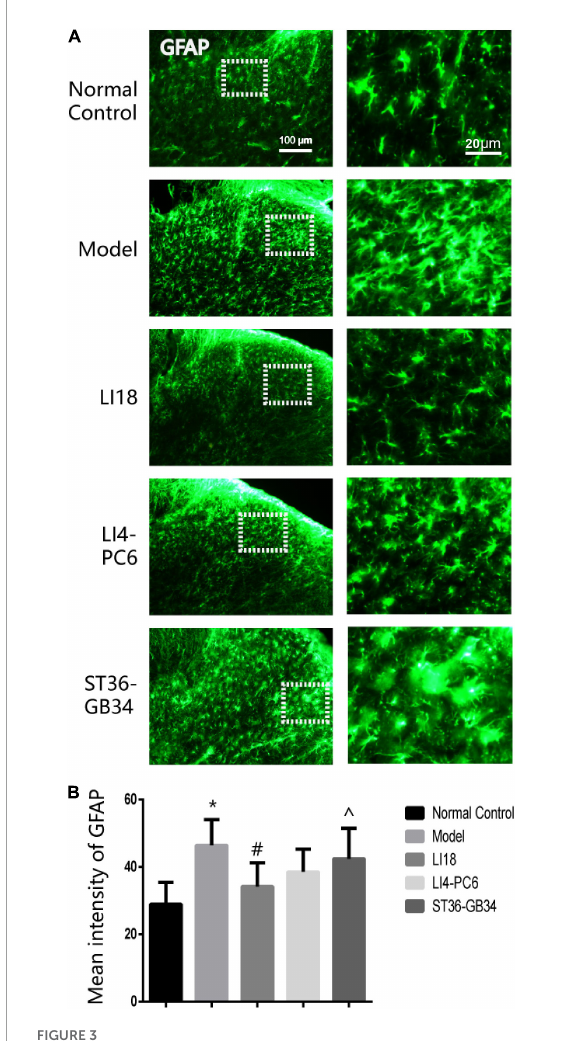
FIGURE3 Effect of electroacupuncture (EA) on activities of astrocytes in dorsal horns (DHs) of cervical spinal cord at 24 h after neck incision in different groups. (A) Representative fluorescence micrographs of immunofluorescence staining of GFAP for astrocytes in the cervical (C2–C5) spinal DHs in the five groups. The magnified astrocytes shown in the right column images were chosen from the dashed squares of the right column images in the five groups. The scale bar in the five images on the left column is 100 µ m, and 20 µ m in the five images on the right column. (B) Bar graphs showing the mean intensity of glial fibrillary acidic protein (GFAP) immunoreaction (IR) in the DHs (mean ± SD, n = 5/group). One-way ANOVA analysis revealed that the mean intensity of GFAP IR was significantly increased in the model group (vs. the control group), and considerably decreased in the EA LI18 but not in the EA PC6-LI4 and EA ST36-GB34 groups (vs. the model group). * P < 0.01, vs. the control group, # P < 0.05, vs. the model group, ˆ P < 0.05, vs. the EA LI18 group.